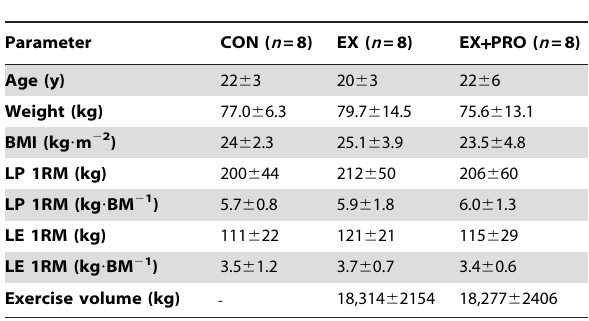
Table 1. Characteristics of participants in each